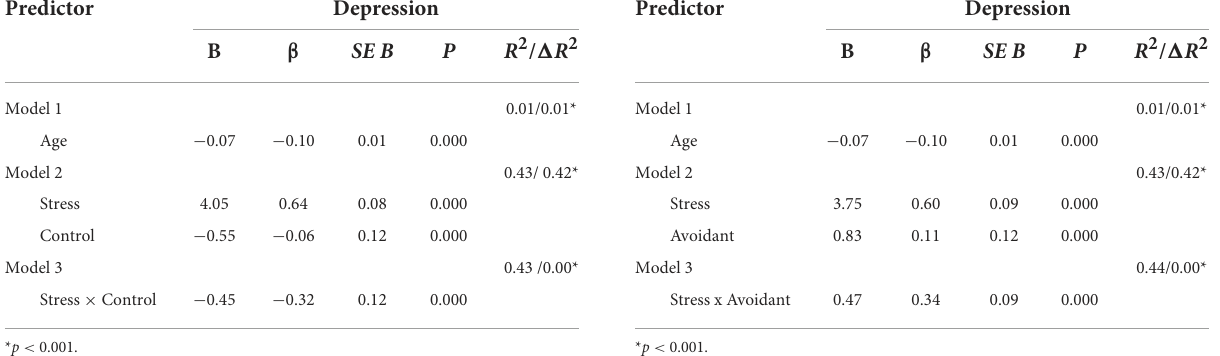
TABLE 3 Regression analysis showing age, stress and control coping as predictors of depression ( n = 3,356). Predictor